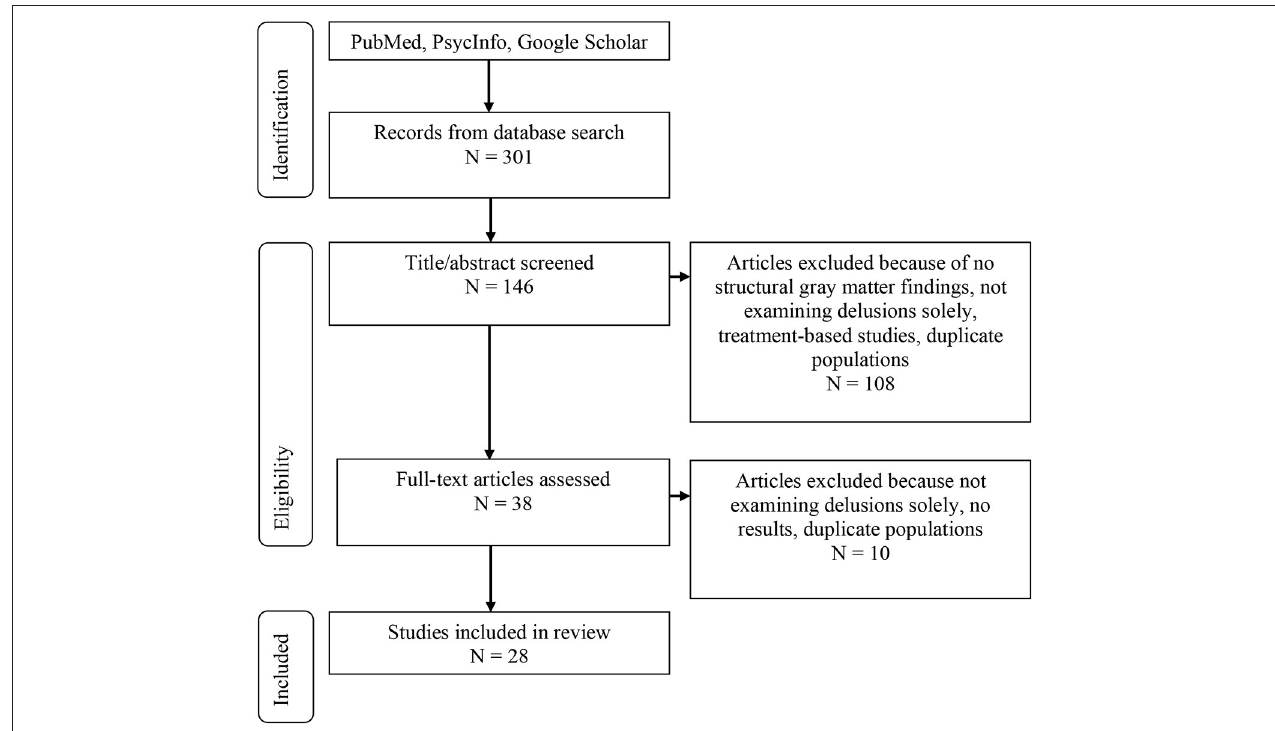
FIGURE 1 | Literature review flow